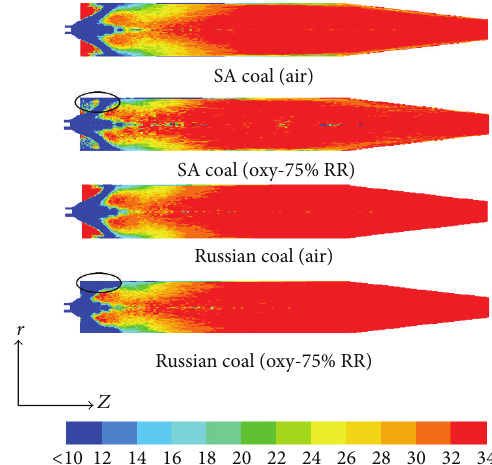
Figure 4: Contours of particle scattering coefficient to particle absorption coefficients ( 𝜎 𝑝 /𝑘 𝑝 ) computed by using varying radiative properties for the combusting particle. Differences in the ignition and burnout predictions are seen in the recirculation zone in the oxy-75%RRscenariosasindicatedbycircleswhencomparedagainst combustion in air.